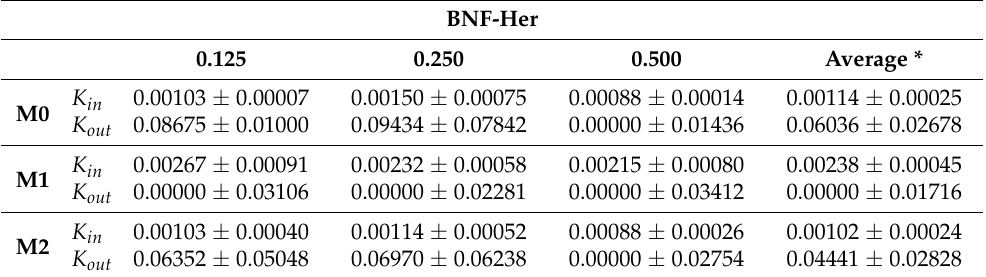
Table 3. Values of K in and K out obtained from the fitting shown in Figure 2 for BNF-Her using mean values.